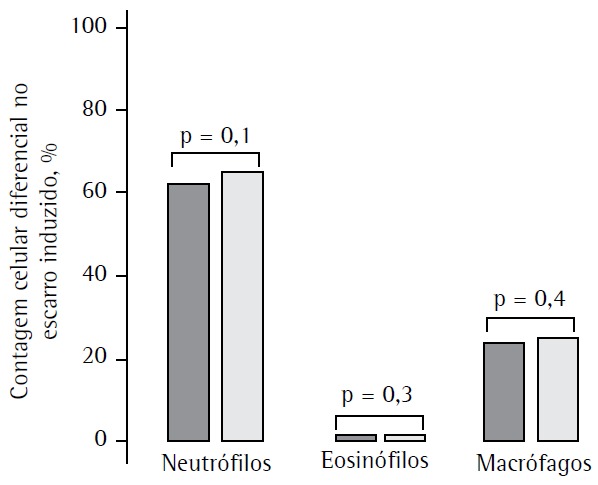
 Mediana da contagem celular diferencial em lâminas coradas com
May-Grünwald-Giemsa (barra cinza escuro) e pela coloração hematológica
rápida (barra cinza claro).